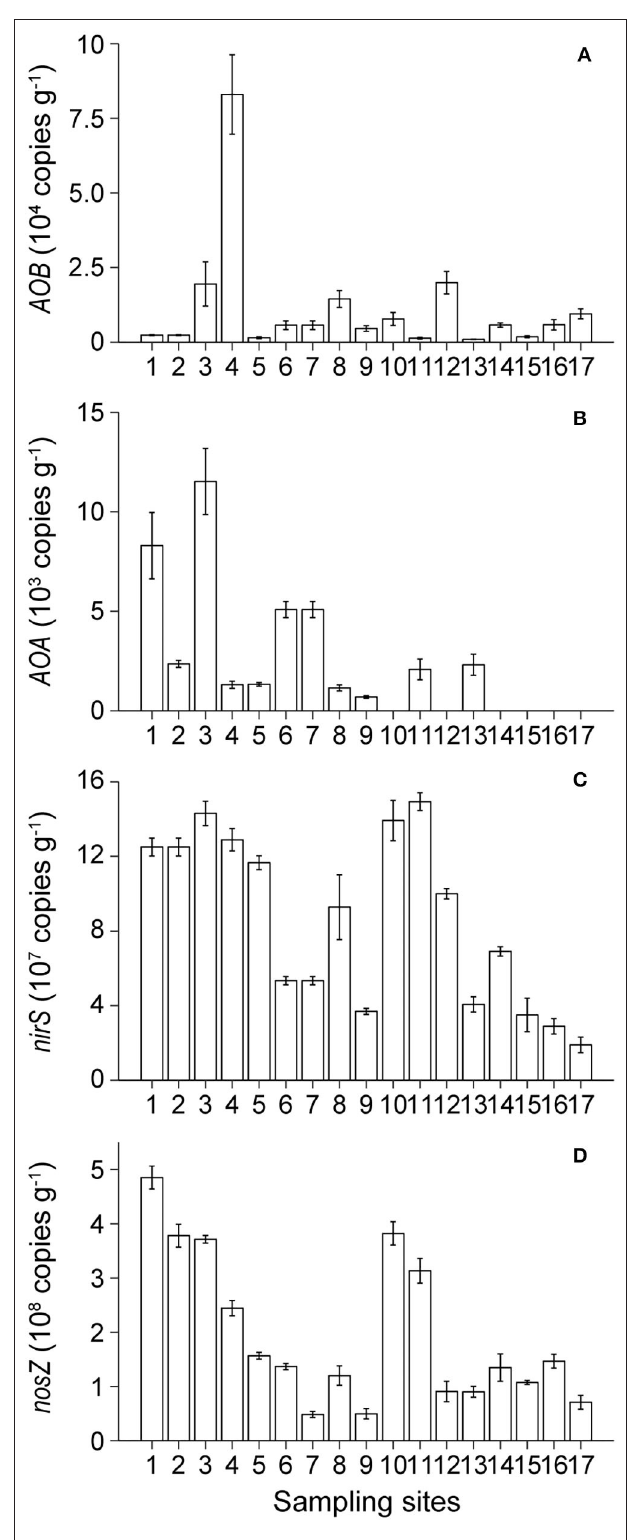
FIGURE 4 | Spatial distribution of the abundances of AOB (A) , AOA (B) , nirS (C) , and nosZI (D) genes in Lake